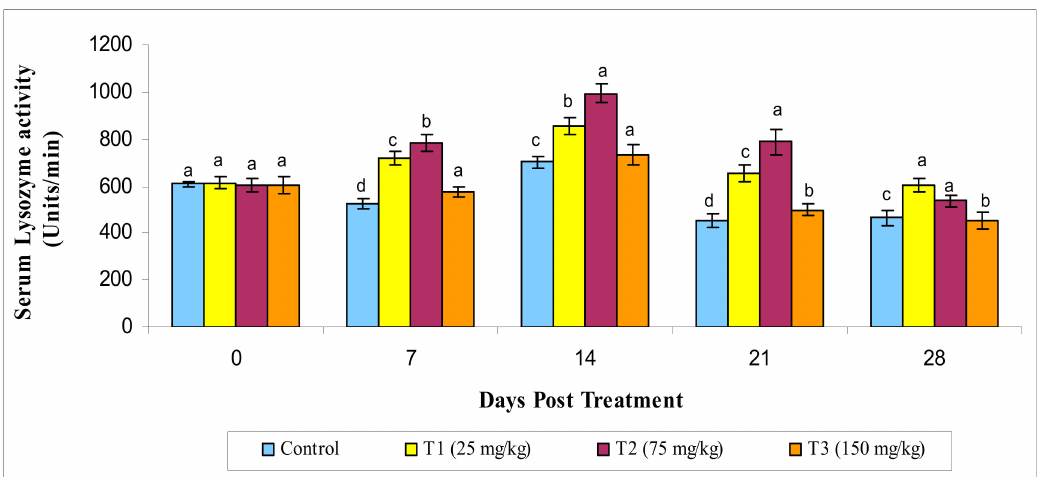
Figure 2. Serum lysozyme activity under di ff erent treatments administered with various levels of methanol extract of Chaetomorpha antennina in Labeo rohita during post treatment days (values are mean ± SE). a,b,c,d Mean values with di ff erent superscripts considered as statistically di ff erent ( p < 0.05); n = 6 for each treatment group.